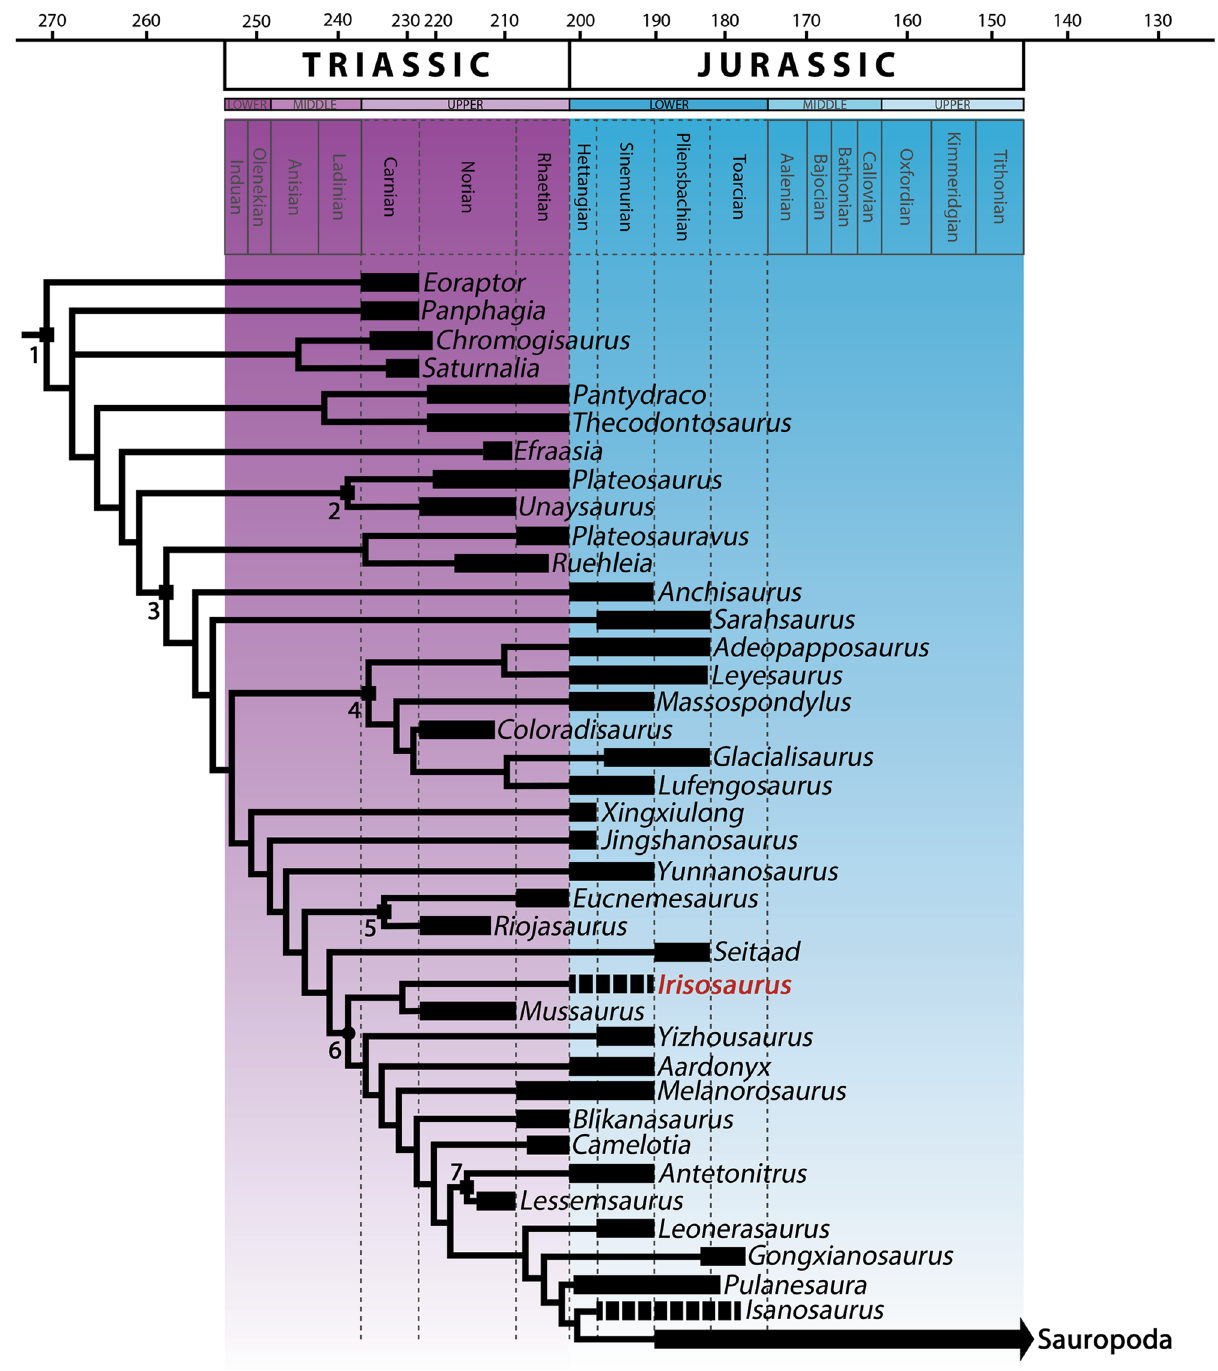
Figure 12. Strict reduced consensus at the genus level of the most parsimonious trees recovered following the phylogenetic analysis. The original dataset is based on the matrix and scorings of Zhang et al. 2019 (except for Irisosaurus ) and includes 62 taxa for 364 characters. This reduced consensus displays 39 taxa. It is based on 2 MPTs of 1,300 steps each (CI = 0.33, RI = 0.69). Dashed lines mean that the exact age of the genus is uncertain. Clades: 1, Sauropodomorpha; 2, Plateosauridae; 3, Massopoda; 4, Massospondylidae; 5, Riojasauridae; 6, Sauropodiformes; 7, Lessemsauridae. Squares represent stem-based definitions, ellipses represent node-based